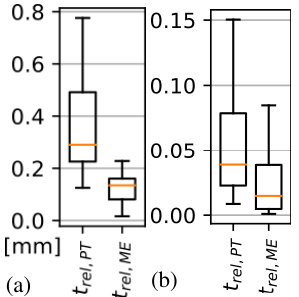
Figure 9. (a) Boxplots of absolute errors; (b) boxplots of relative errors for a relative rotation angle of 5°.